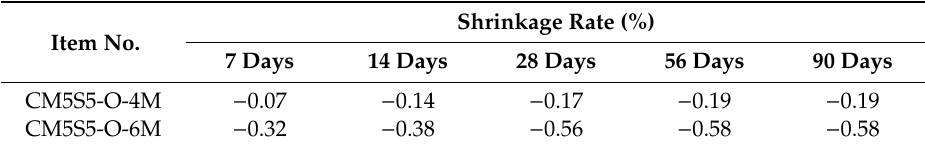
Table 5. Effect of a reduced NaOH molar concentration on shrinkage of marble-based geopolymer E ff ect of a reduced NaOH molar concentration on shrinkage of marble-based concrete. geopolymer concrete.